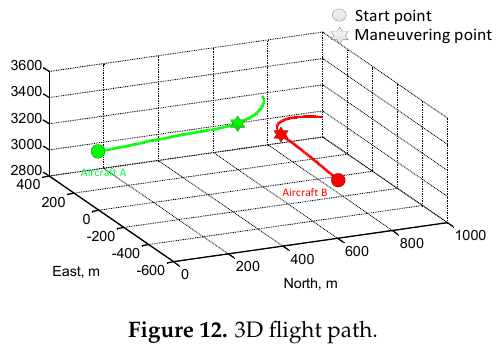
Figure 12. 3D flight path.